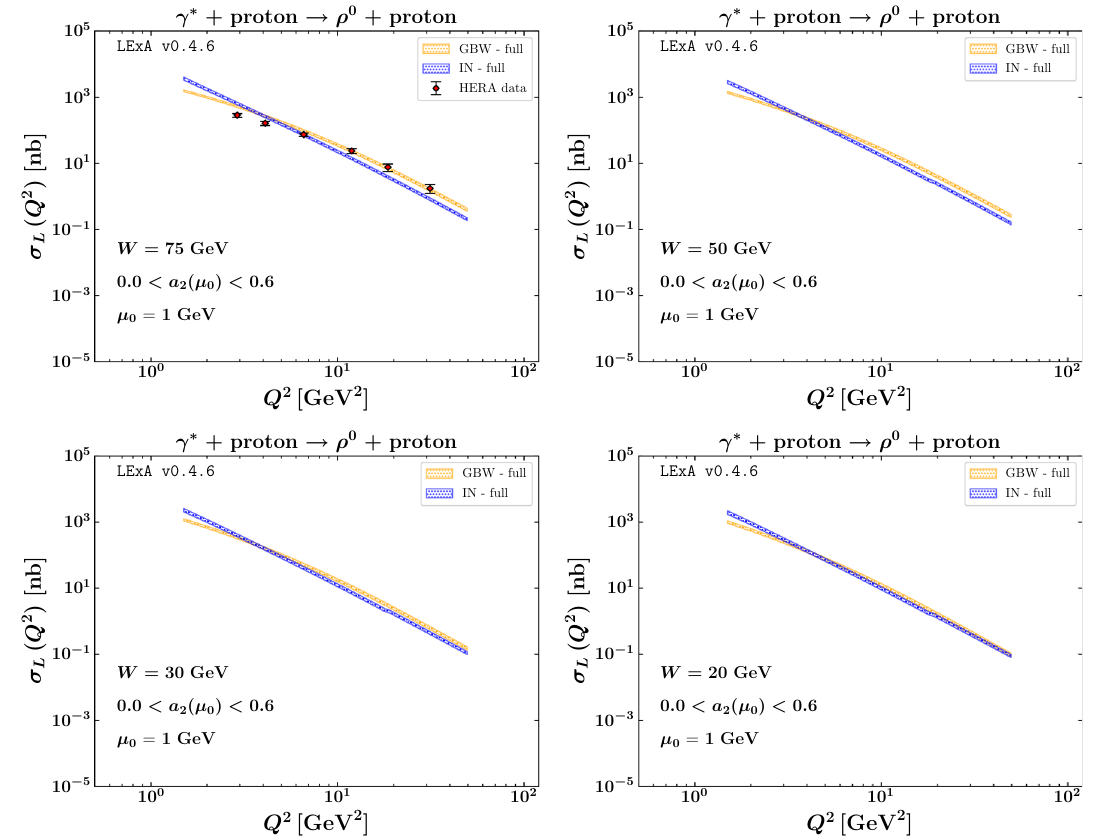
Fig. 6 Q 2 -dependence of the longitudinally polarized cross section, σ L , for GBW and IN UGD models, at W = 75 GeV together with the HERA data (left upper panel) and at W = 20 , 30 , 50 GeV EIC (the remaining panels). Uncertainty bands represent the effect of varying a 2 (μ 0 = 1GeV ) between 0 . 0 and 0 .